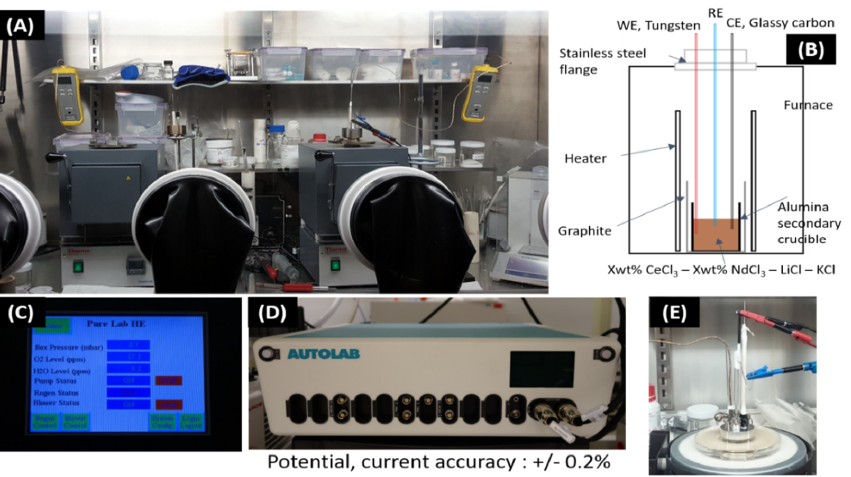
Figure 1. Experimental setup and instruments. ( A ) Ar atmosphere glove box. ( B ) Schematic diagram of experimental apparatus. ( C ) Oxygen and moisture monitoring. ( D ) Autolab / PGSTAT128N potentiostat ( E ) Electrode setup in glove